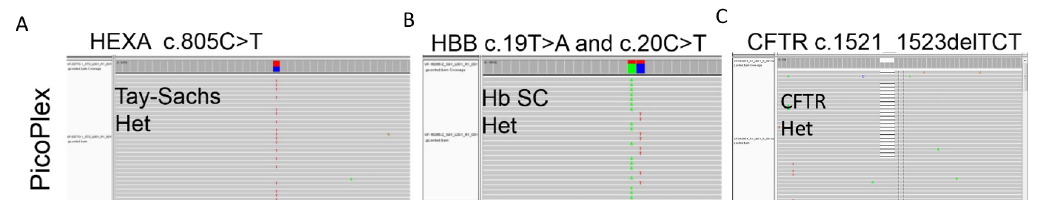
Fig 7. Testing for sequence variants in single lymphoblasts. From left to right, Tay-Sachs, HEXA c.805C > T het; HBB c.19T > A and c.20C > T compound het; CFTR c.1521_1523delTCT het. The reads are shown in the IGV